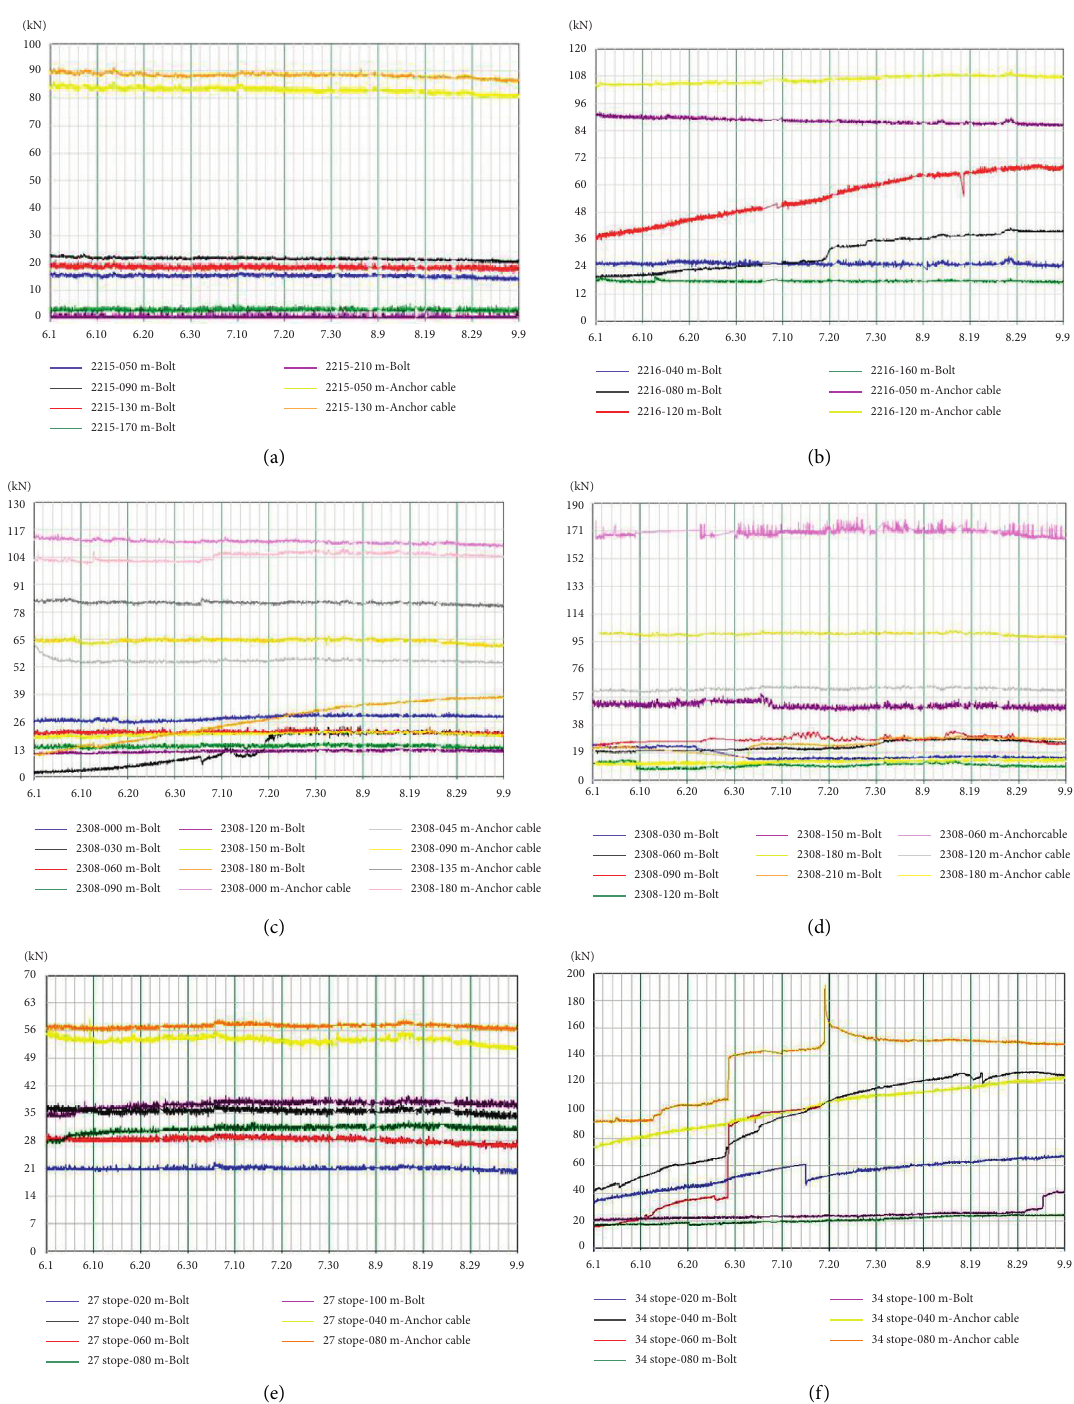
Figure 12: Force of bolt and anchor cable monitoring curves in the (a) XV2215 roadway, (b) XV2216 roadway, (c) XV2308 ventilation roadway, (d) XV2308 concentrated roadway, (e) #27 stope roadway, and (f) #34 stope